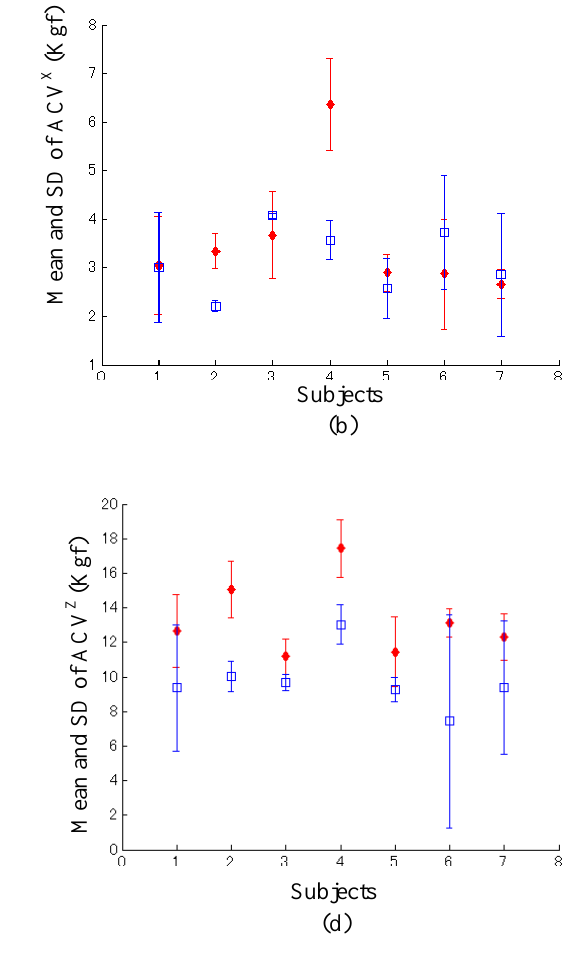
Figure 7. Statistical comparison of evaluation parameters’ (Acop, ACVX, ACVY and ACVZ) mean and standard deviations (SD) of each subject for the three selected speeds required in the two sets of trials. The square markers and deviation scopes represent the evaluation parameters’ mean and standard deviations (SD) in the first set of trials where subjects were required to walk along a lead line; and the diamond markers and deviation scopes are used to represent the second set of trials where subjects were asked to walk bypassing some